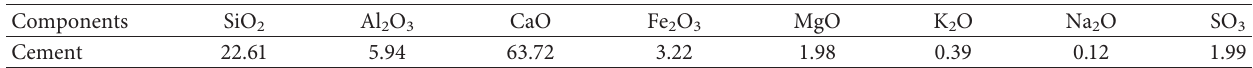
Table 3: Chemical analysis of the cement (wt%).